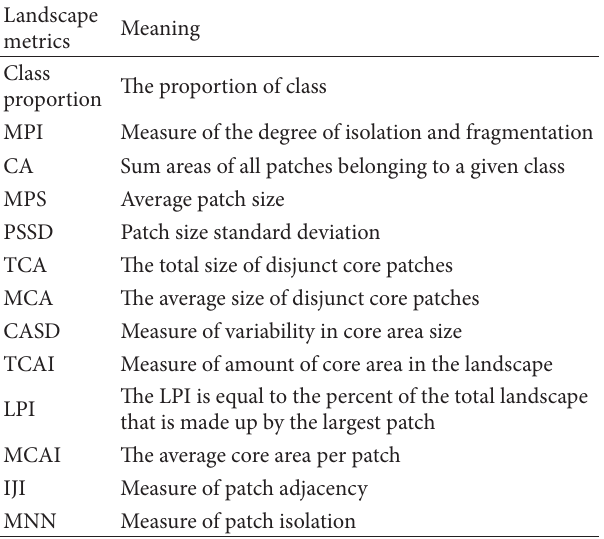
Table 3: Landscape metrics of water and their corresponding meaning, according to the Patch Analyst Help of